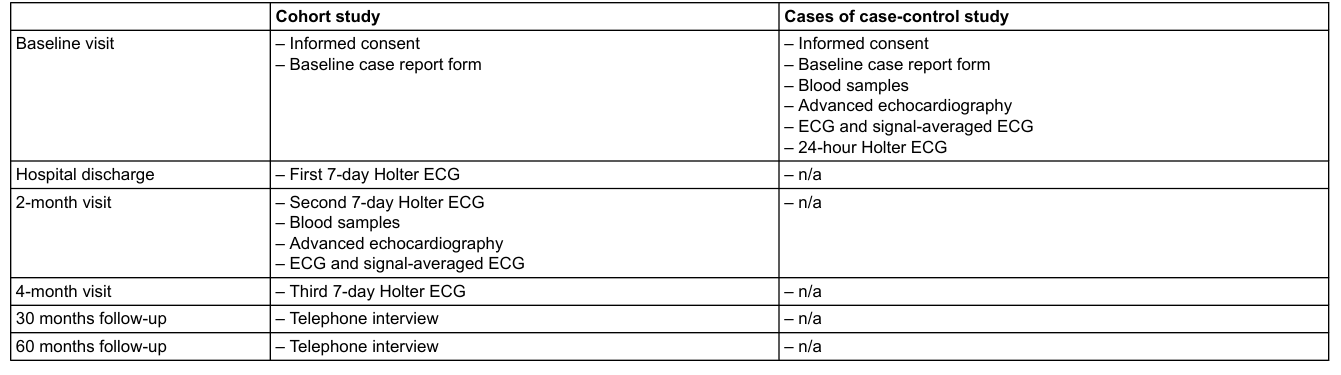
Table 2: Overview of study procedures.